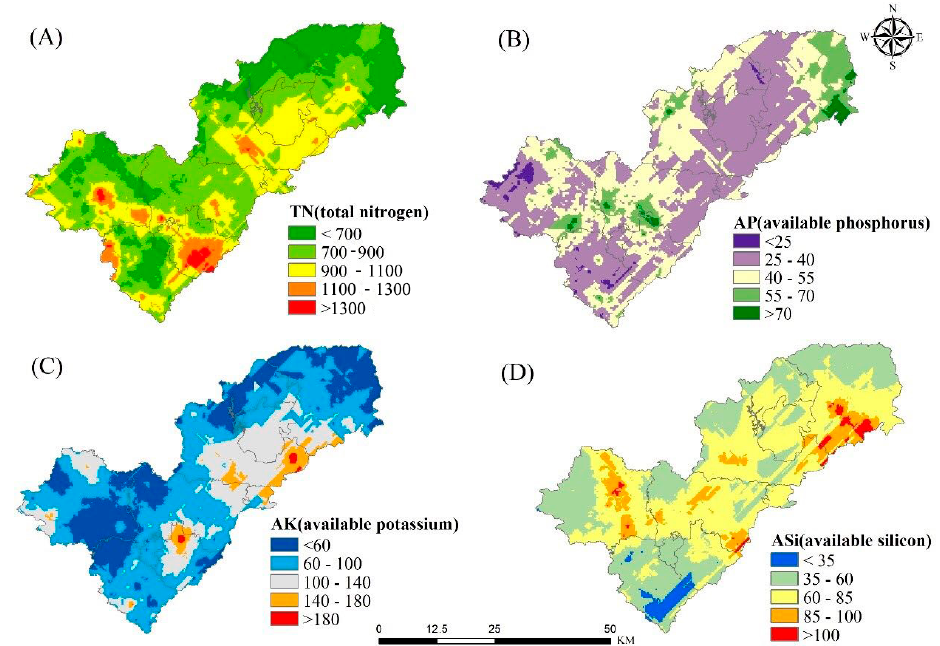
Figure 4 Figure 4. Spatial distribution of TN ( A ), spatial distribution of AP ( B ), spatial distribution of AK ( C ), and spatial distribution